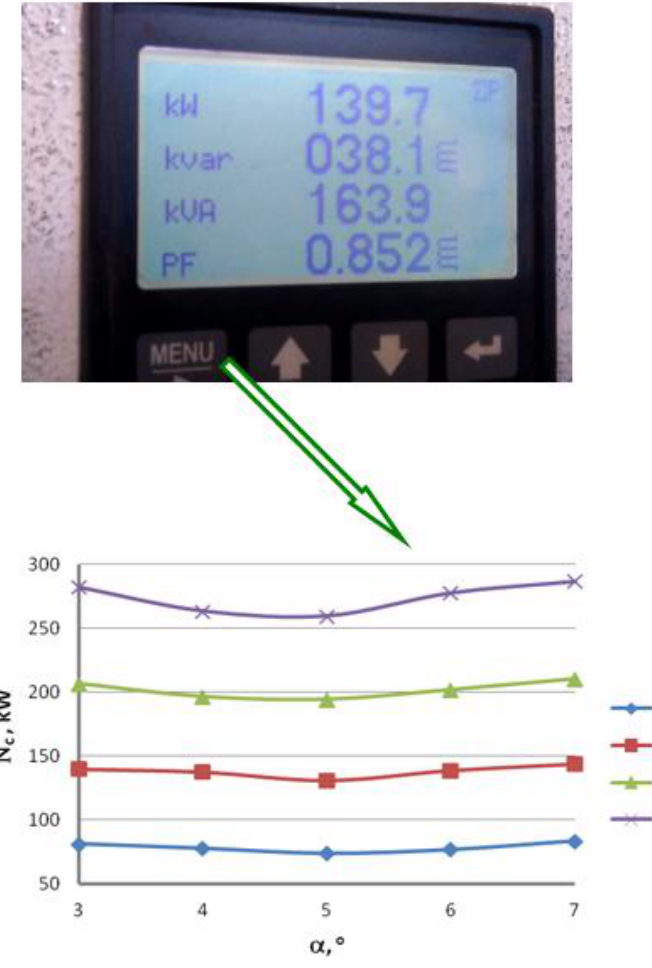
Figure 6. Power consumption reading field by the Mario Frigerio machine and the total drawing power as a function of a drawing angle for the wires drawn with a speed of v = 5, 10, 15 and 20 m/s.